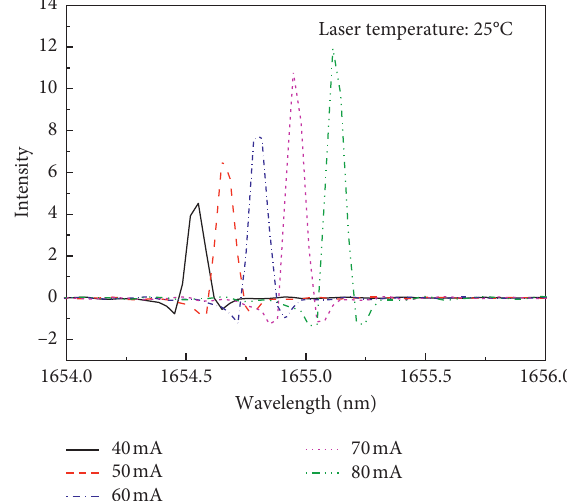
Figure 9: Under the driving current of 70mA, the measured emitting spectrum under different operation temperatures of 17–23 ° C.